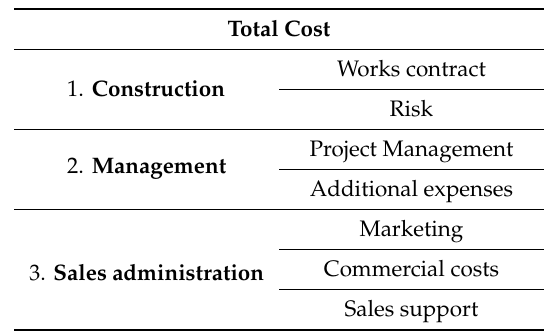
Table 1. Cost structure for a building housing real estate program.